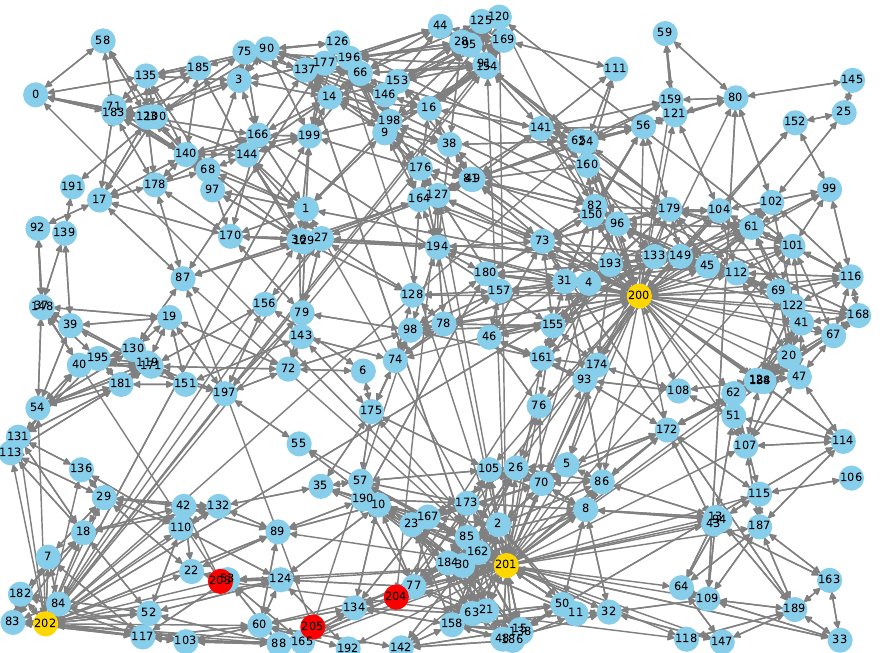
Figure 1. Example of a synthetic network generated through our algorithm. We depict common agents in blue, influencers in yellow, and bots in red. We observe the appearance both of geographical clusters involving nearby nodes and of interest-based clusters, joining groups of nodes located far from one another.